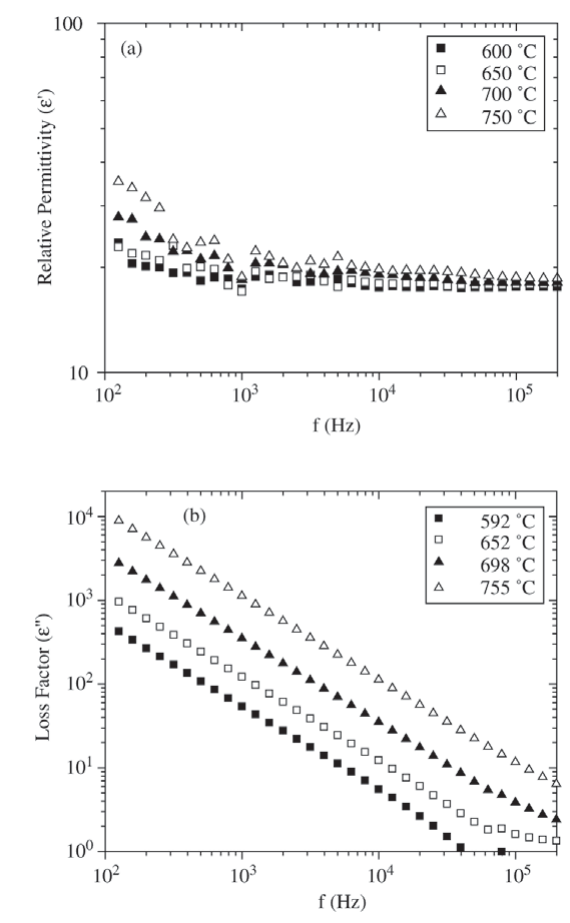
Figure 6. (a) Real part of permittivity ε ’; (b) imaginary part of permittivity ε ’’ as a function of frequency at several temperatures for Bi Ge O single 4 3 12